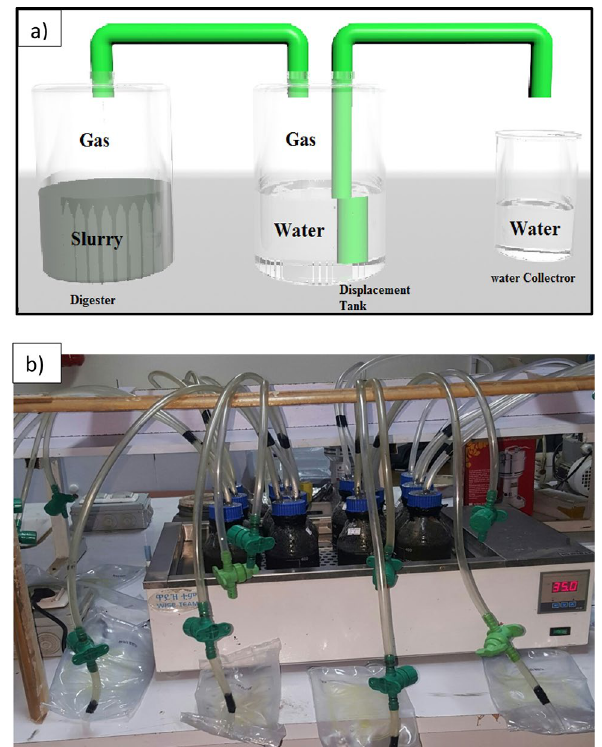
Figure 1. HYPERLINK "sps:id::fig1||locator::gr1||MediaObject::0" ( a ) Schematic diagram of the experimental setup for small-scale anaerobic digestion. ( b ) Experimental setup for biogas production on a laboratory scale.